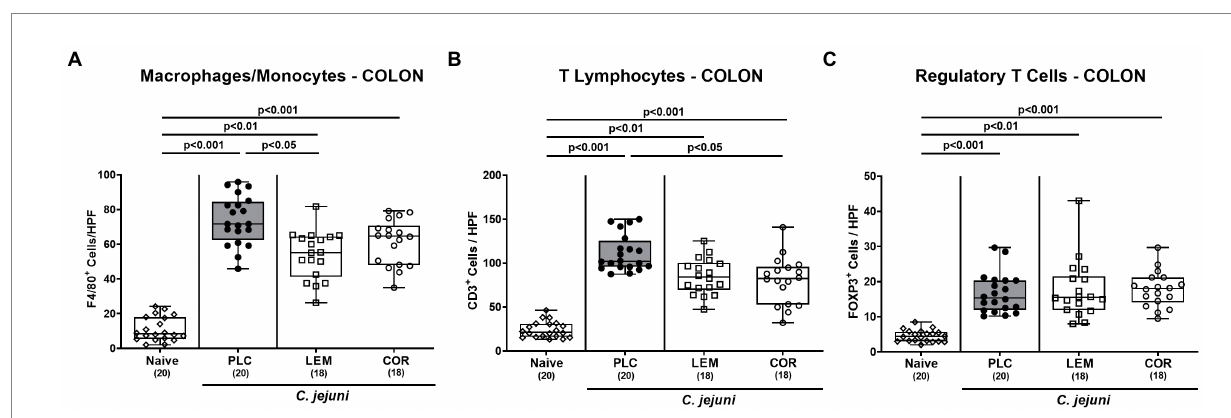
FIGURE 4 Immune cell responses in the colon following prophylactic oral application of lemon or coriander essential oil to C. jejuni infected mice. SAB IL-10 − / − mice were subjected to prophylactic lemon (LEM; white squares) or coriander (COR; white circles) essential oil via the drinking water ( ad libitum ) starting seven days prior infection. Placebo (PLC; black circles) control animals received tap water only. On days 0 and 1, mice were then perorally infected with C. jejuni strain 81–176 by gavage. On day 6 post-infection, the average numbers of (A) macrophages and monocytes (F4/80 + ), (B) T lymphocytes (CD3 + ), and (C) regulatory T cells (FOXP3 + ) per mouse were determined in immunohistochemically stained colonic paraffin sections from six high power fields (HPF, 400 × magnification). Naive mice were included as non-infected, untreated controls (white diamonds). Box plots (indicating the 25th and 75th percentiles), whiskers (indicating the minimum and maximum values), medians (black bar inside box) and numbers of analyzed mice (in parentheses) are shown. Significance levels ( p values) were calculated by the one-way ANOVA test with Tukey post-correction (A,B) and